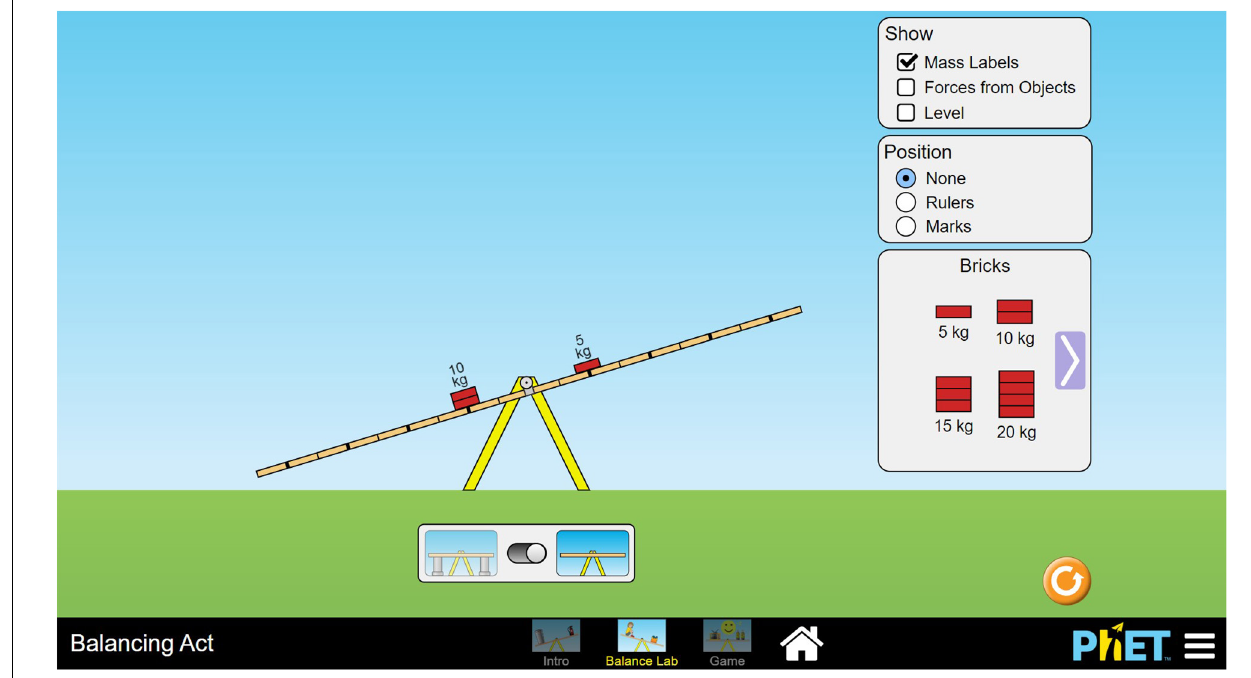
FIGURE 1 | The virtual lab with the balance beam that was used during the inquiry-based lesson.